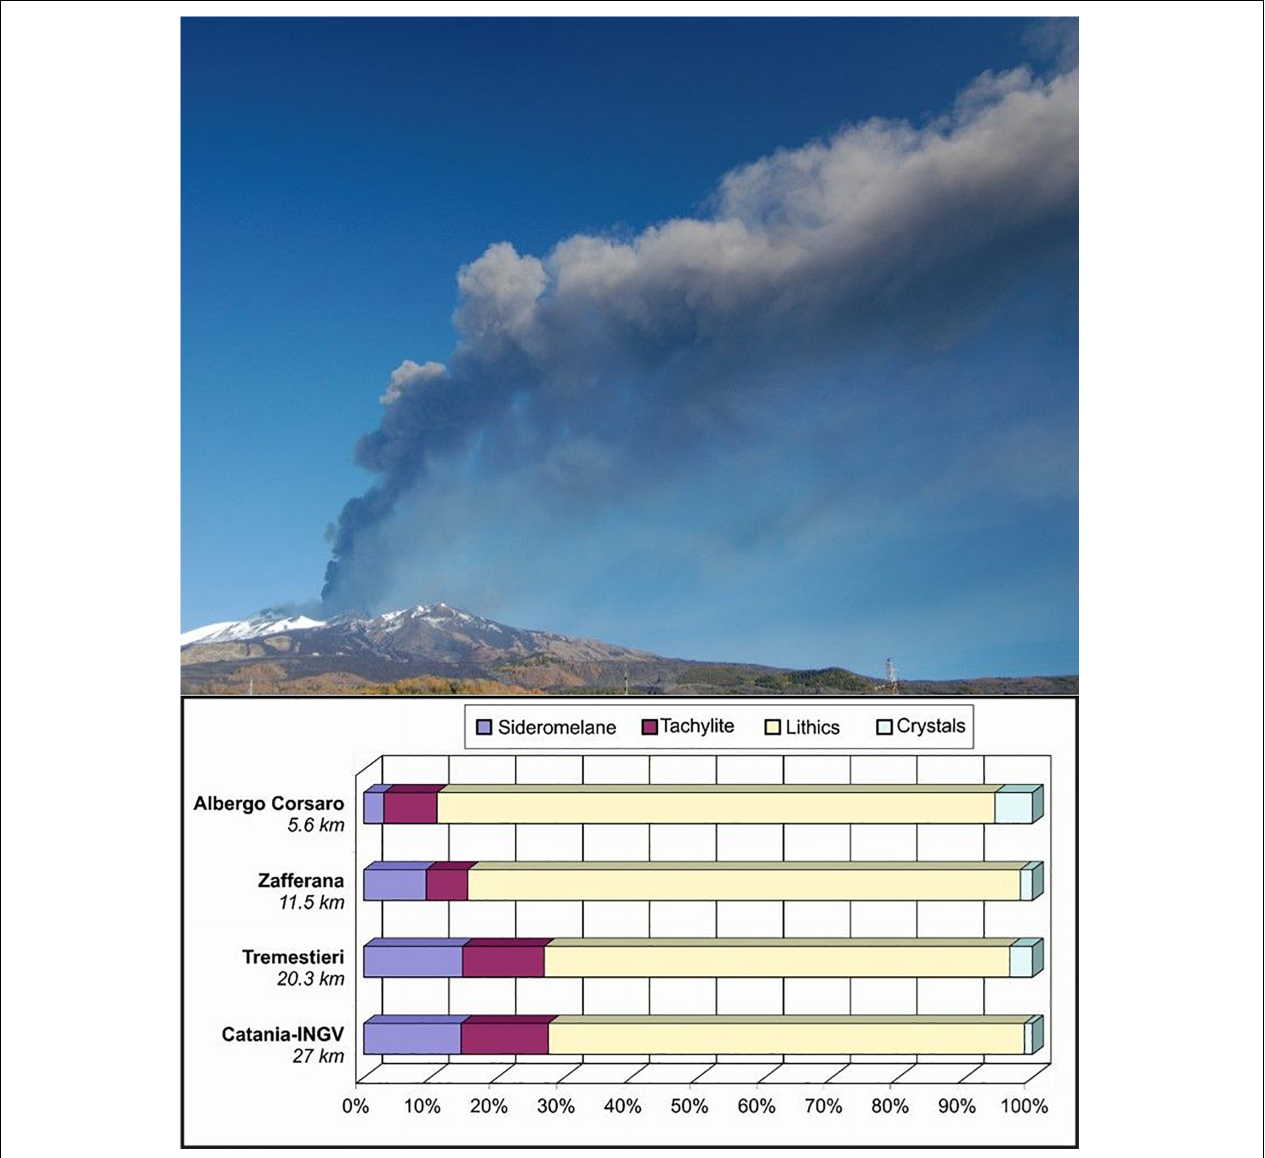
FIGURE 4 | Plume of the 24 November 2006 activity (from Polacci et al., 2009) and diagrams illustrating the relative abundance of ash componentry at different distances from the vent. Reproduced with